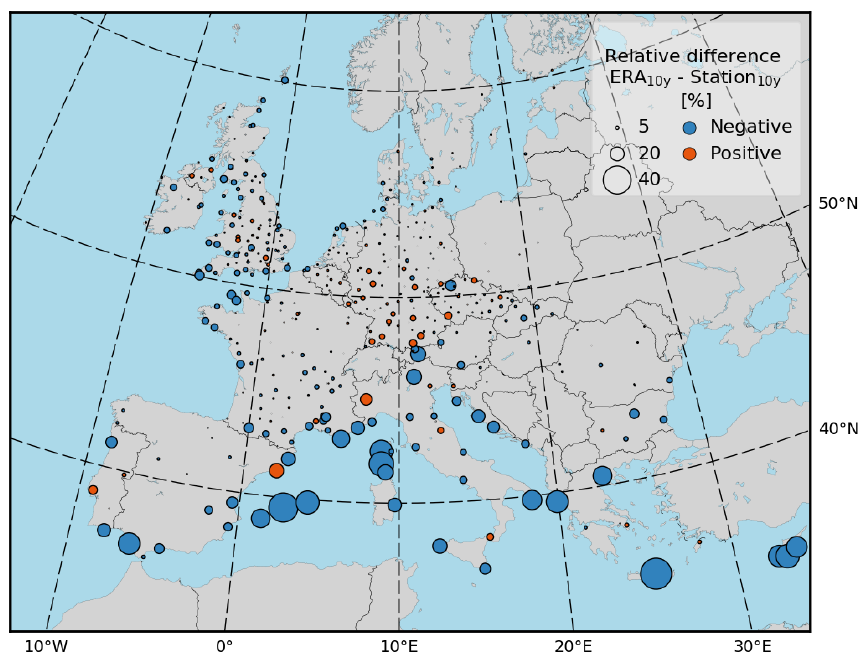
Figure 7. Map showing relative difference (in %) in EnergyPlus calculation for heating energy calculation when using the full 10-year ERA data instead of the 10-year station data. This calculation is for the single-family house